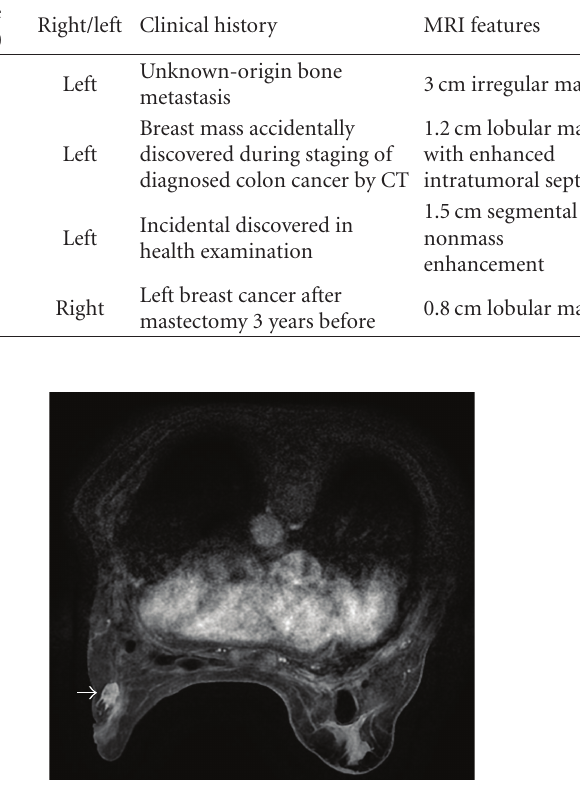
Figure 3: Axial fat-suppressed postcontrast breast MRI shows a 3cm enhanced irregular mass with focal irregular (white arrow) in the left breast under compression before MRI-guided biopsy. It was diagnosed as ILC by the biopsy.